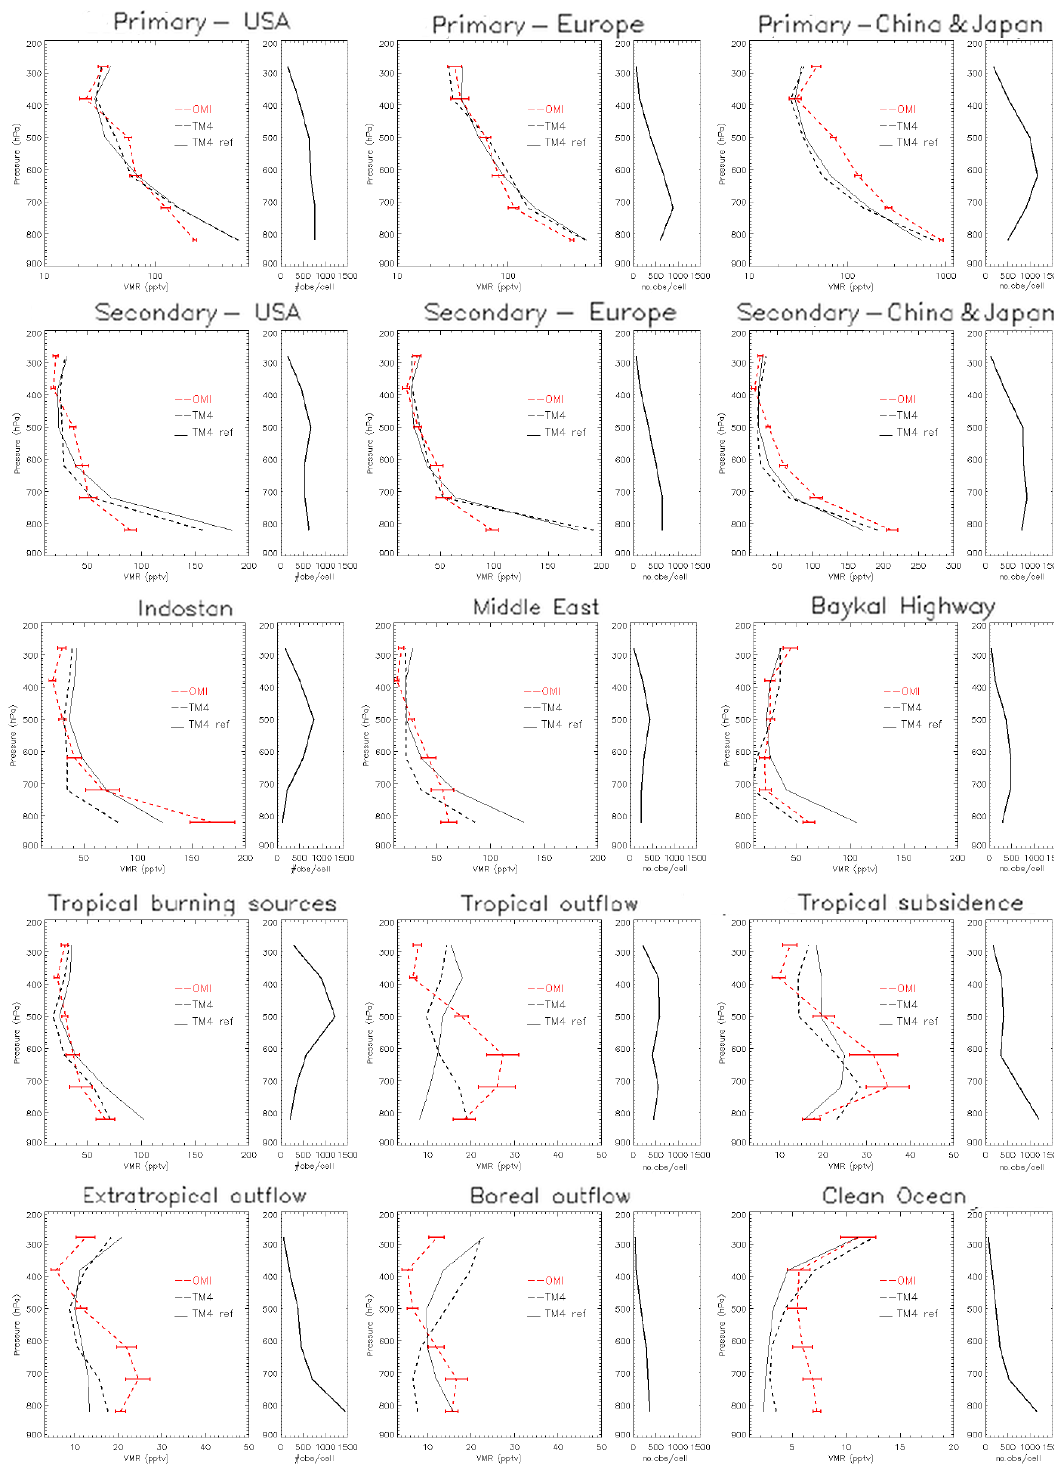
Figure 8. Cloud-slicing NO 2 VMR profiles for the year 2006 by class (OMI pseudoprofile, dashed red line; TM4 pseudoprofile, dashed black line; TM4 profile for cloudy conditions, continuous black line). The error bars show random retrieval errors. The differences between continuous and dashed black lines show systematic pseudoprofile errors. The subpanels on the right show the average number of OMI observations collected per grid cell per year for that